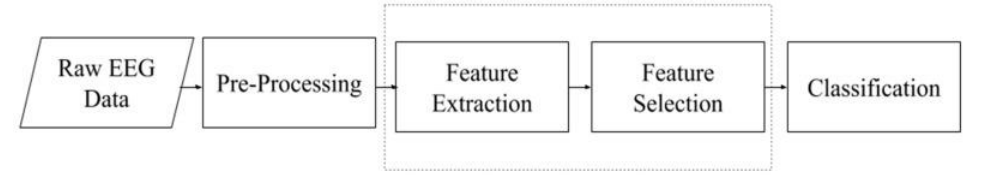
Figure 1. Typical MI EEG-based signal processing and classification system.